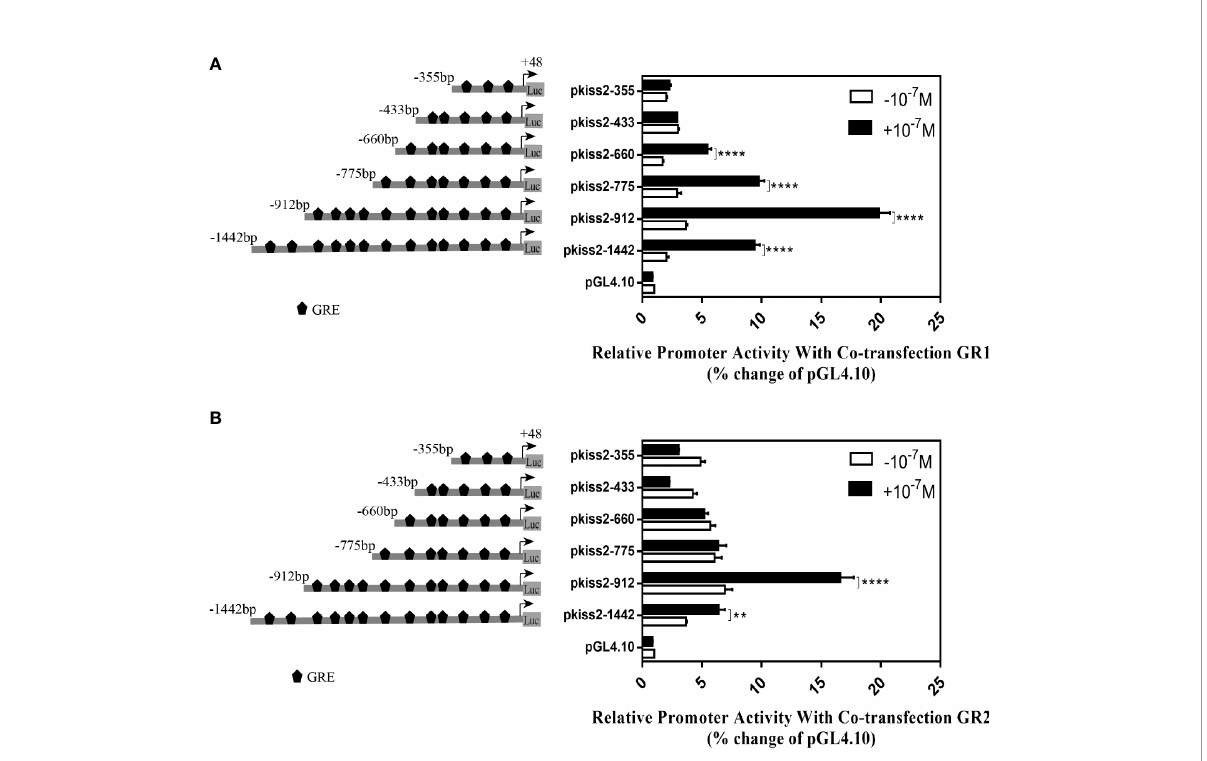
FIGURE 7 Deletion analysis of the kiss2 promoter. Schematic of the putative GRE sites and deletion constructs of kiss2 promoter is shown on the left. HEK-293T cells were transfected with deletion constructs and pRL-CMV with GR1 (A) or GR2 (B) expression plasmid. Cells were incubated with or without 10 − 7 M cortisol treatment. Relative promoter activities are expressed as percentage of pGL4.10 in the absence of cortisol. Data are represented as mean ± SEM (n = 4). **(p < 0.01) and **** (p < 0.0001) indicate the signi fi cant differences compared with the corresponding